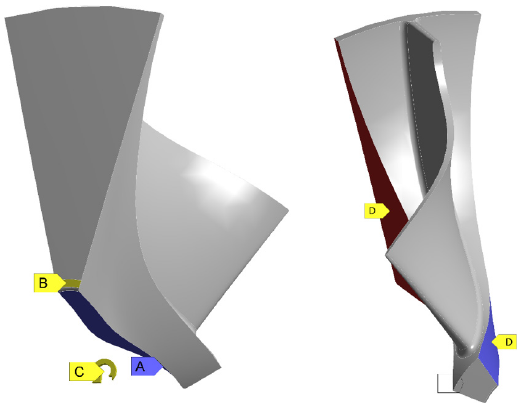
Figure 13: Assumed boundary conditions